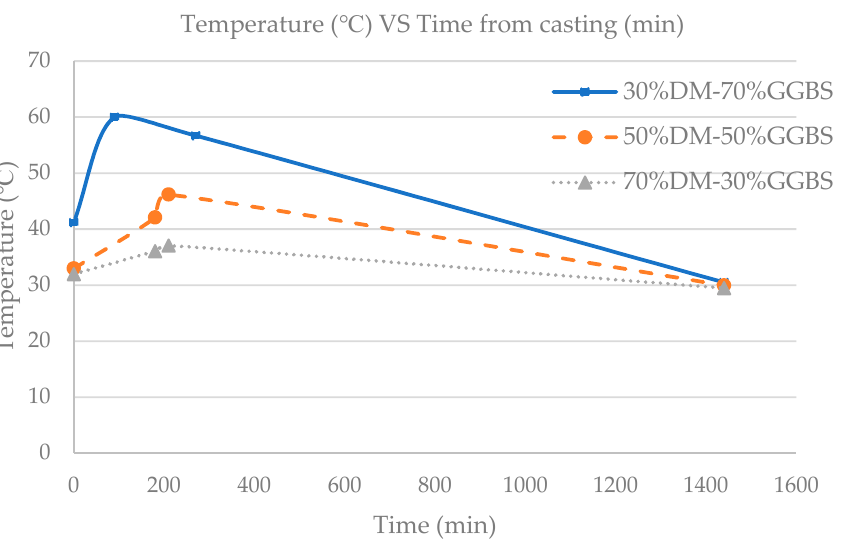
Figure 2. Setting (mm) vs. time (min) plots for the 3 DM–GGBS mixtures developed.